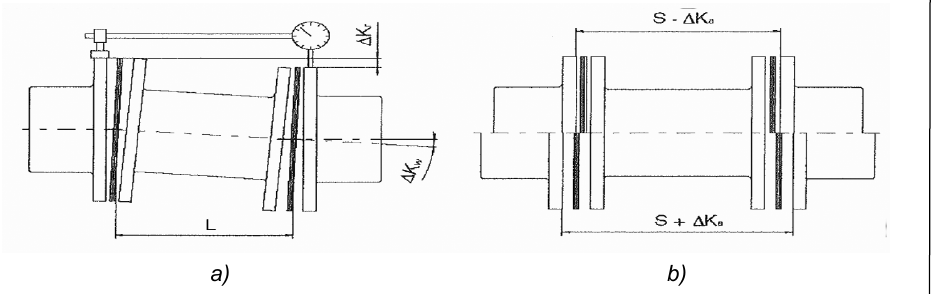
Figure 20 – Measurement of variations in the 3-D system in flexible couplings Flender ARPEX series K 430 Рисунок 20 – Измерение расхождений в системе 3-D эластичной муфты типа Flender ARPEX серии K 430 Слика 20 – Мерење одступања у 3-D систему на еластичним спојницама типа Flender Arpex, сериј e K